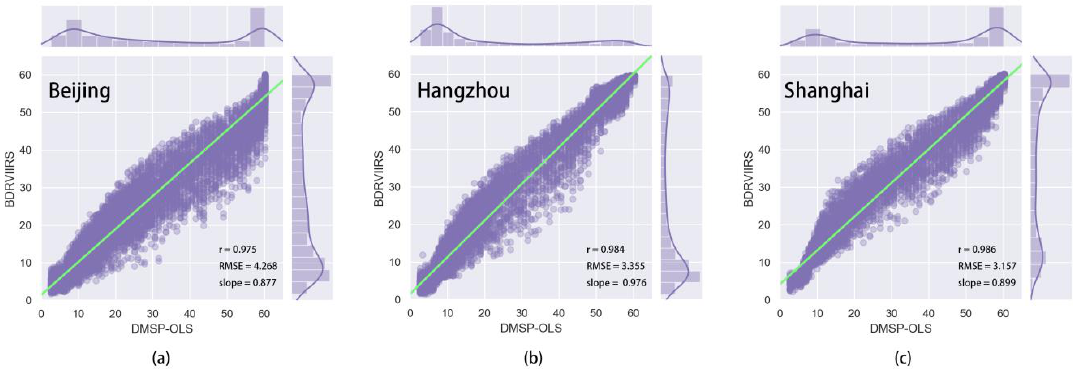
Figure 10. Histogram, scatterplots and linear fit lines of DMSP-OLS data and BDRVIIRS data of the three cities in 2013 (a, b and c).